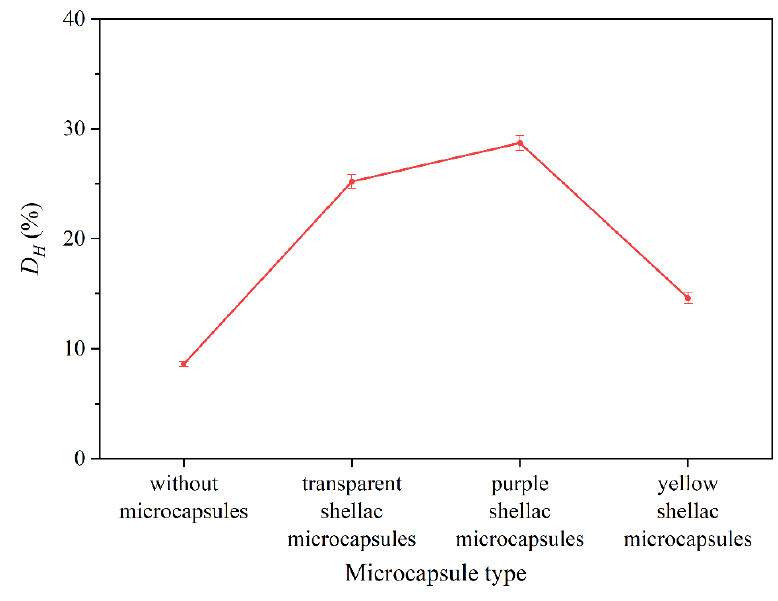
Figure 16. Results of width change rate before and after repair.